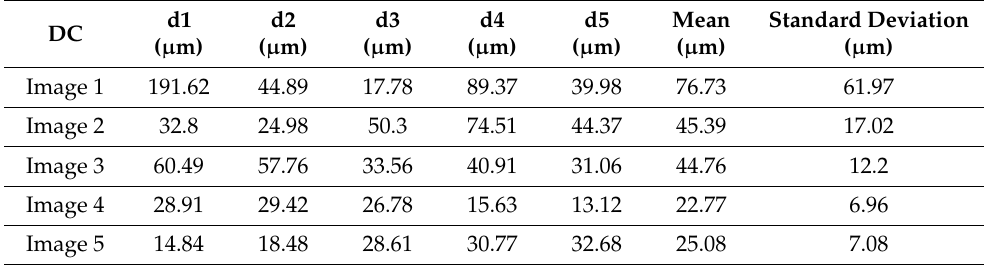
Table 6. Measurements of the gap present at the joint between the components of the assembly ( µ m) of prosthetic frameworks made by direct construction and resin model detachment method-DC.